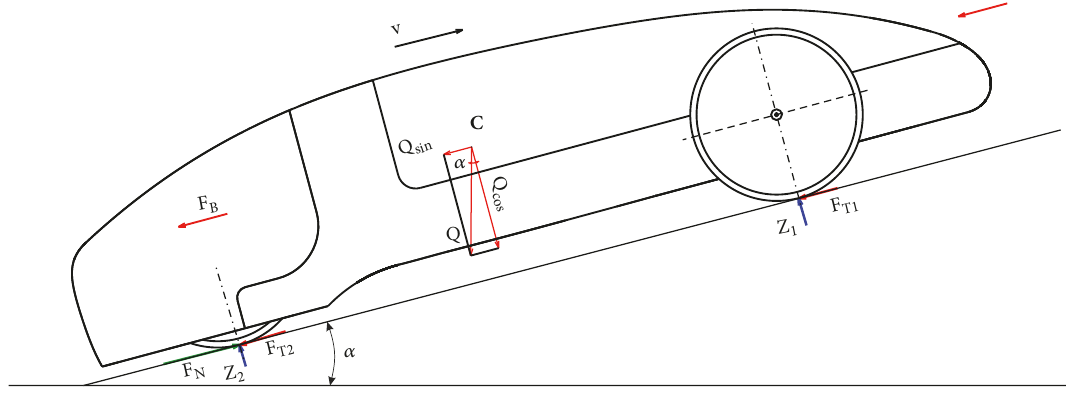
Figure 4: The system of forces acting on the